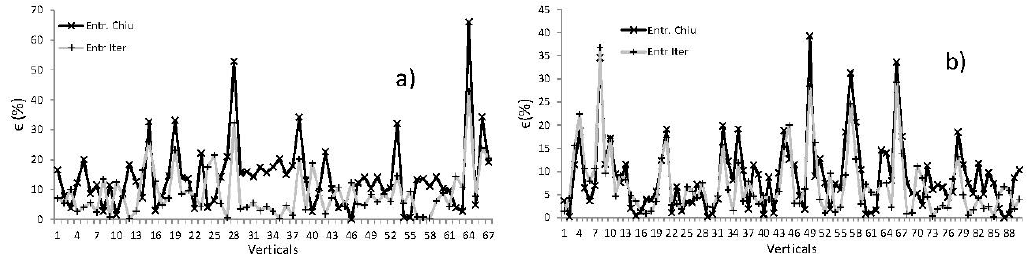
Figure 5. Absolute percentage error in estimating the depth ‐ averaged velocity using the dip assessment by the iterative procedure proposed here (Entr Iter) and Chiu’s formula (Entr Chiu) for ( a ) the Rosciano and ( b ) the Pontelagoscuro gage sites.